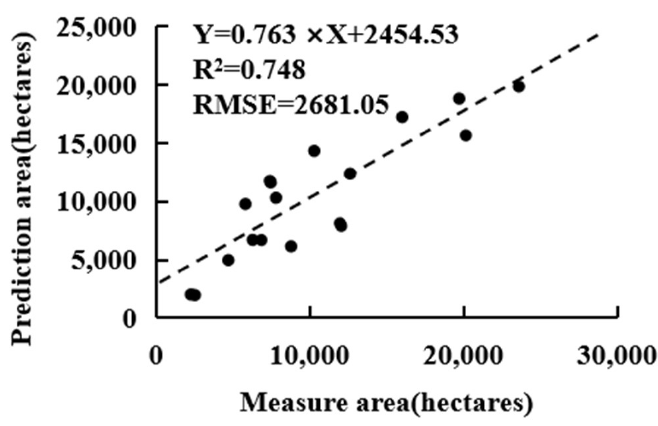
Figure 9. Comparison between the measured and predicted beetle-infested total area using linear regression models. Dashed line is the regression line; RMSE, root mean square error.